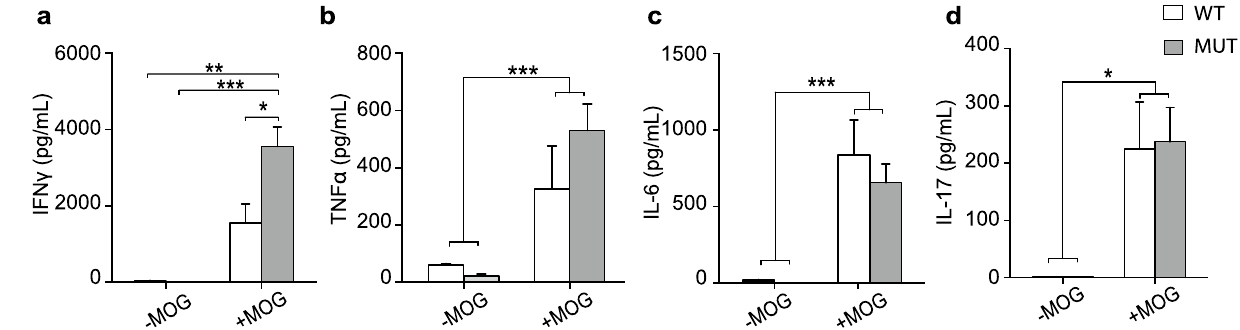
Figure 4. Cytokine production by splenocytes isolated during chronic stage of EAE. Concentration of cytokines produced by splenocytes from WT-EAE and MUT-EAE animals cultured for 72 h in the absence or presence of MOG (− MOG/+ MOG). For all cytokines analyzed ( a ) IFNγ, ( b ) TNFα, ( c ) IL-6, and ( d ) IL-17, MOG stimulation induced a higher and statistically significant production compared to unstimulated cells. Also, MUT splenocytes secreted significantly more IFNγ than WT splenocytes in response to MOG. All values are presented as media ± SEM. Two-way ANOVA and Tukey post hoc test were performed. *p < 0.05; **p < 0.002; ***p < 0.0002. WT-EAE n = 5; MUT-EAE n =